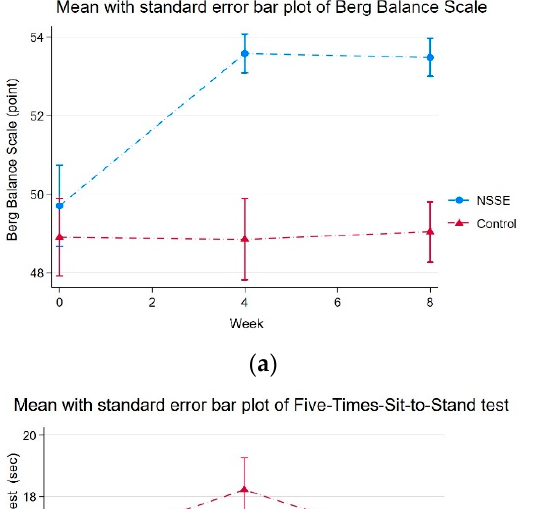
Table 2. Changes in physical performance parameters in the NSSE group and the control group over the 8-week period.